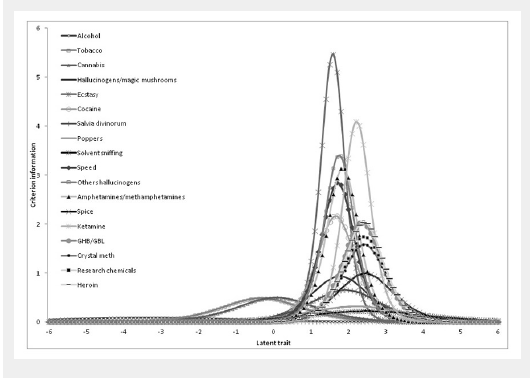
Criterion information curves for drug use. The criterion information curves represent how each criterion measured the underlying latent trait. The point on the x-axis where the probability of endorsement (y-axis) is 50% determined the severity parameter. The discrimination parameter of each criterion is the slope: the steeper slopes had higher discrimination parameters. Thus, ecstasy and ketamine discriminate very strongly between different drug users (high values on the y-axis), whereby ecstasy is less severe (more left = 1.59) compared with ketamine (more to the right with severity = 2.23) as regards the latent trait (substance use severity). (Detailed values can be found in table 4.)